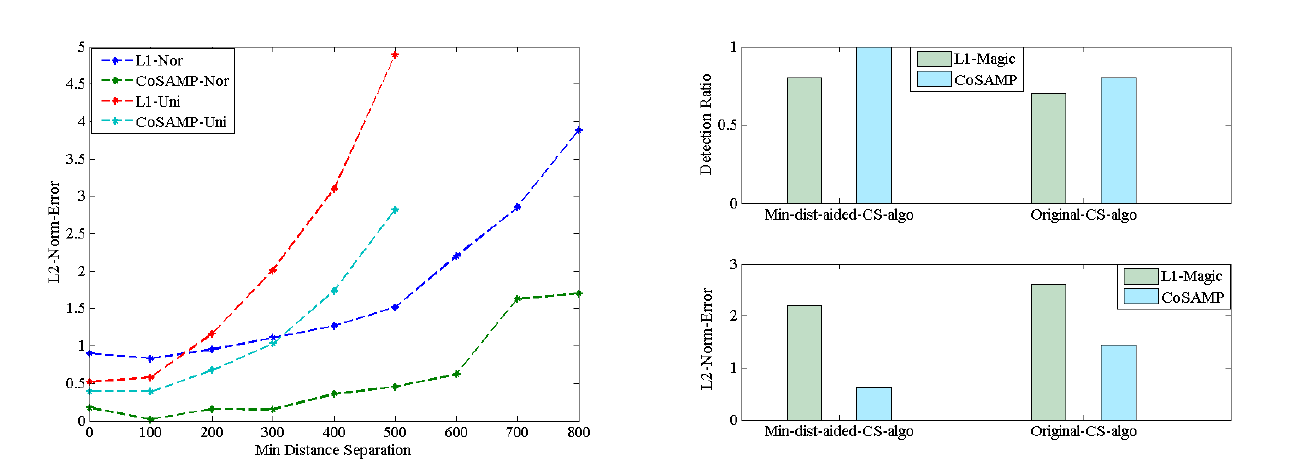
Figure 11. Detection ratio and Error comparison of proposed algorithm compared to original CS algorithm